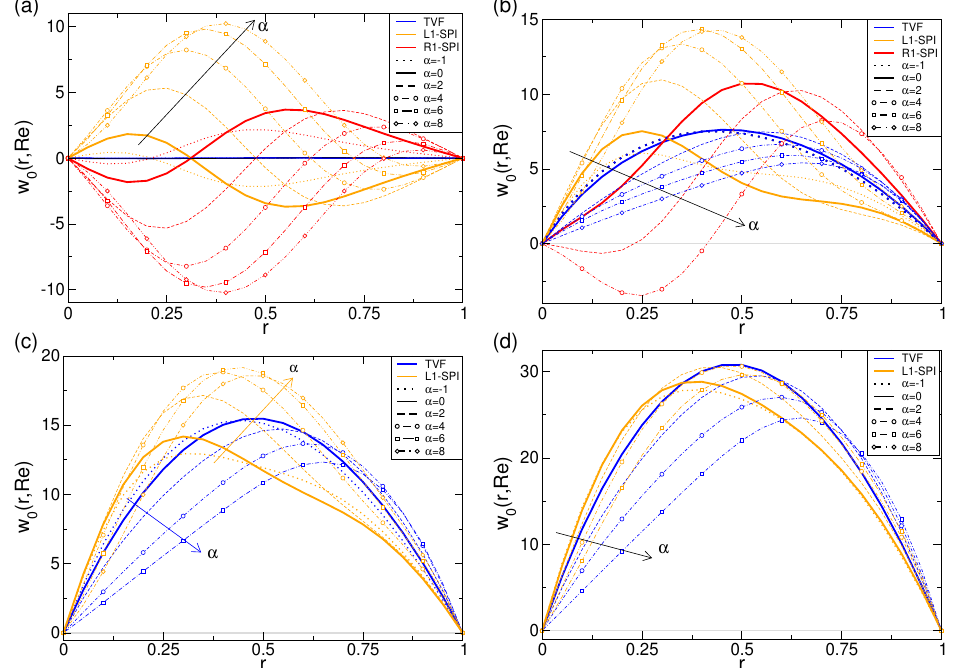
Figure 9. Radial profiles of the axial mean flow w 0 ( r ) (Equation (13)) of TVF, L1-SPI, and R1-SPI (see also Figure 6) for ( a ) Re = 0, ( b ) Re = 5, ( c ) Re = 10, and ( d ) Re = 20 at α as indicated. The thick line refers to α = 0. Note the change in amplitude of w 0 ( r ) (ordinate scaling) for larger Re . In ( a ) at Re = 0 the w 0 ( r ) = 0 for TVF and therefore not